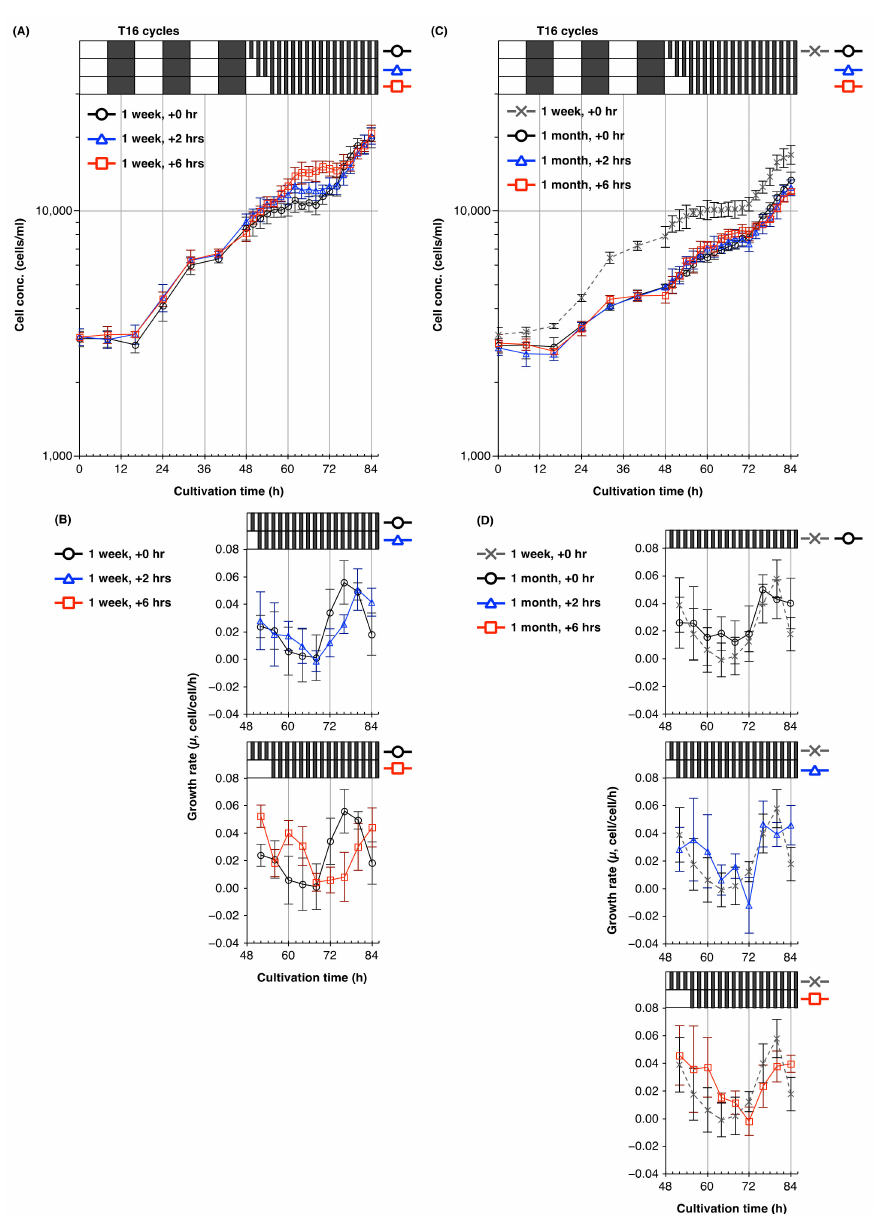
Figure 6. Plasticity of the period of cell division cycle of E. gracilis from young and old cultures. Time courses of the ( A , C ) cell concentration and ( B , D ) growth rate ( µ , cell/cell/h) of E. gracilis cells from 1-week-old ( A , B ), and 1-month-old ( C , D ) cultures under free-running conditions beginning at different start times. E. gracilis cells were cultured under T24 cycles for 1 week and 1 month, and subsequently inoculated into fresh medium. After entrainment to 3 × T16 cycles, algal cells were irradiated for 0, 2, or 6 h, and then released to free-running conditions (1 h/1 h light/dark cycles). Data are means ± SD ( n = 4). Growth rates under free-running conditions were calculated over 4-h